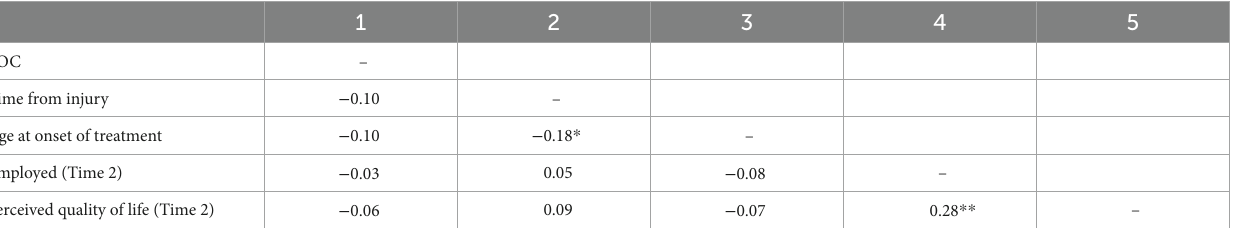
TABLE 2 Correlations between study